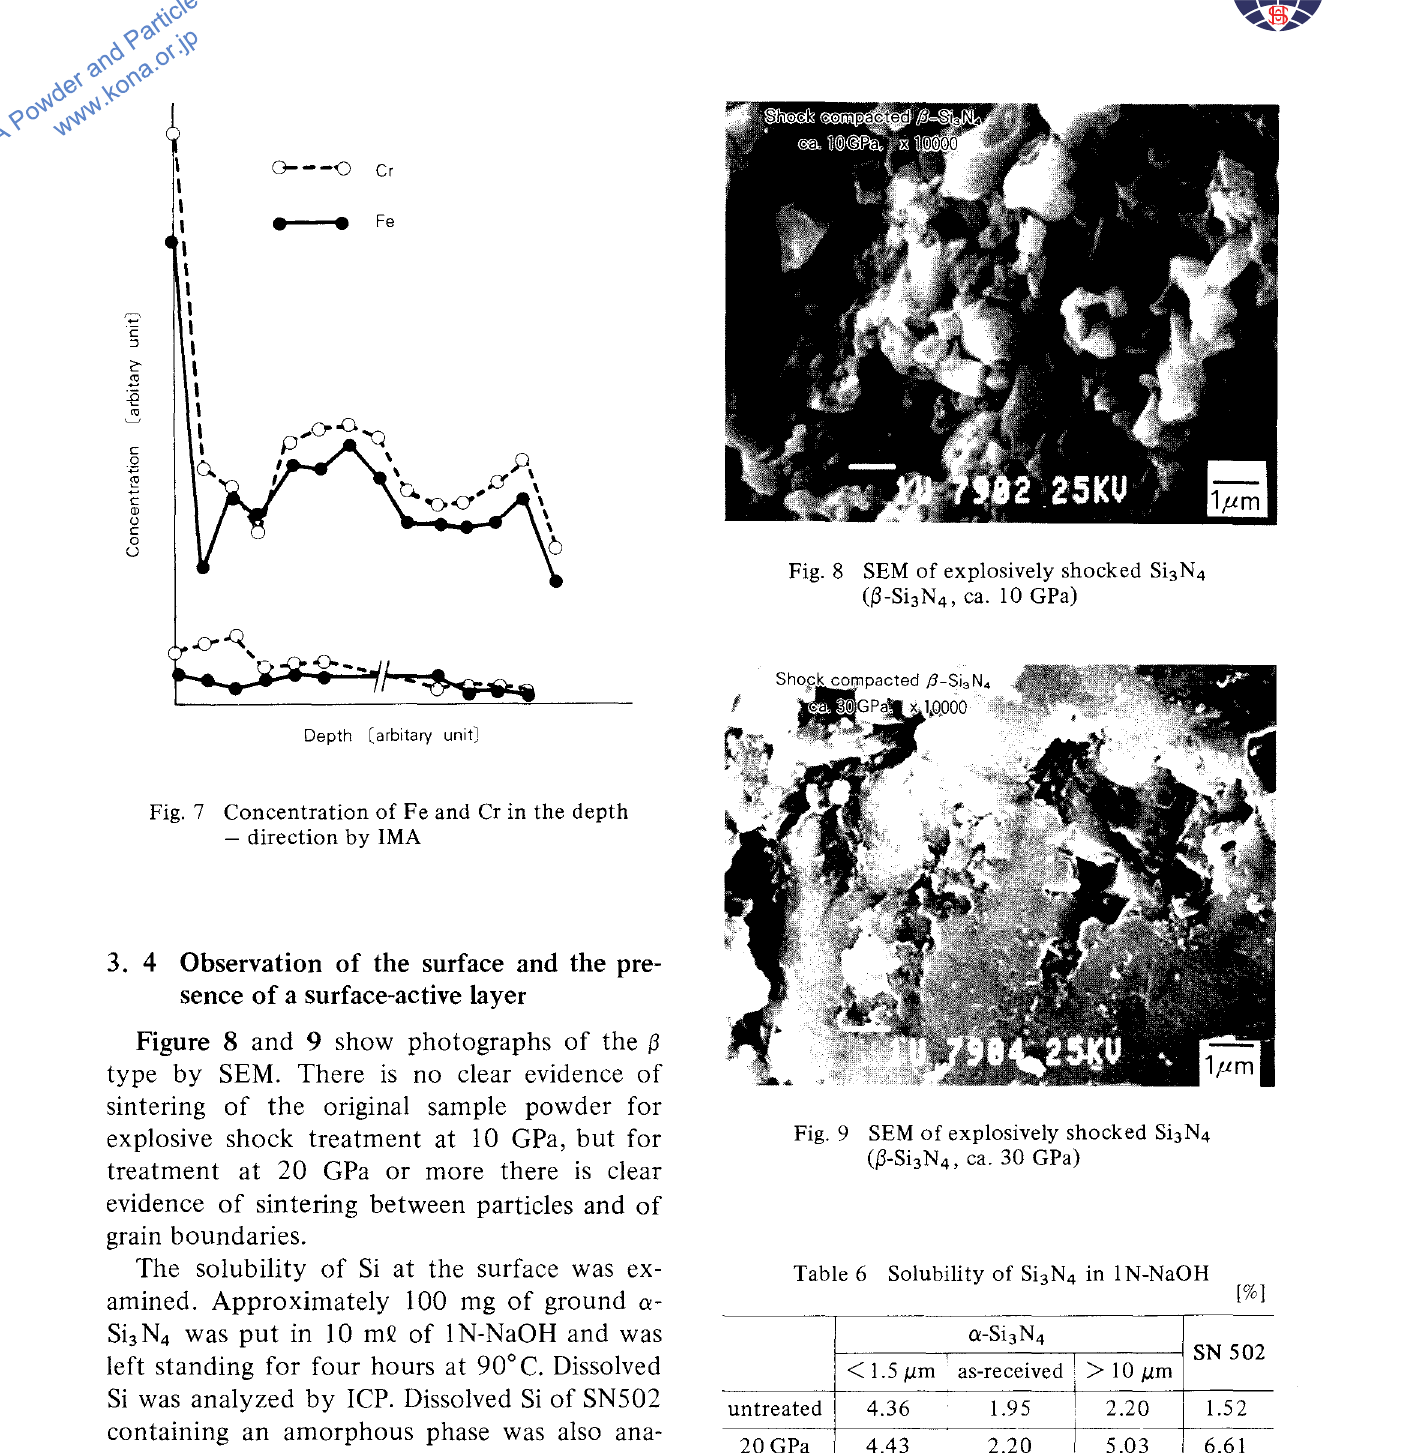
Table 6 Solubility of Si3N4 in I